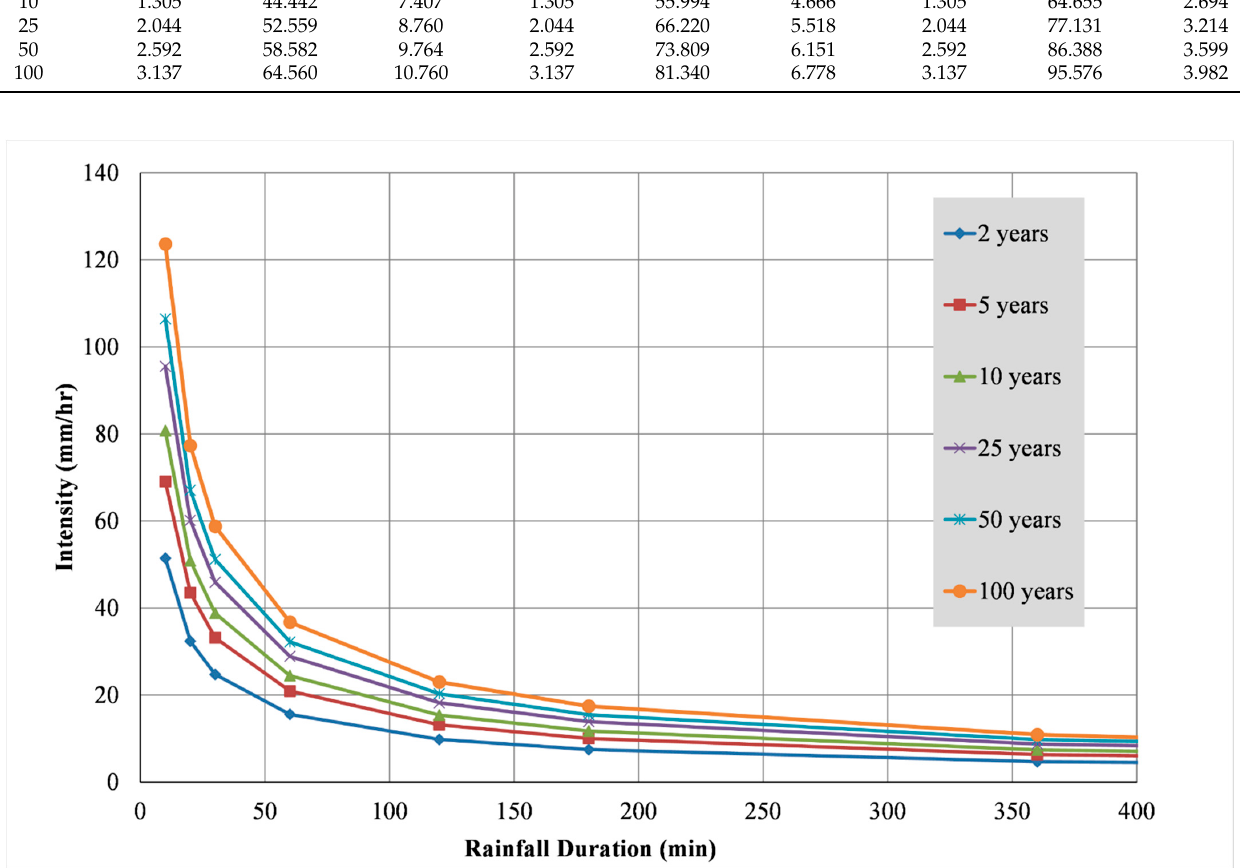
Figure 2. IDF curves generated using the Gumbel method on an ordinary scale.